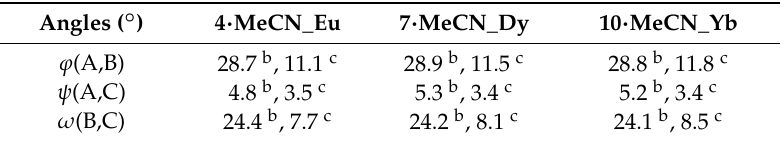
Table 2. Diagnostic angles ( ◦ ) between planes of coordinated salanH in complexes 4 · MeCN_Eu, 7 · MeCN_Dy, and 10 · MeCN_Yb a . Angles ( ◦ ) 4 · MeCN_Eu 7 · MeCN_Dy